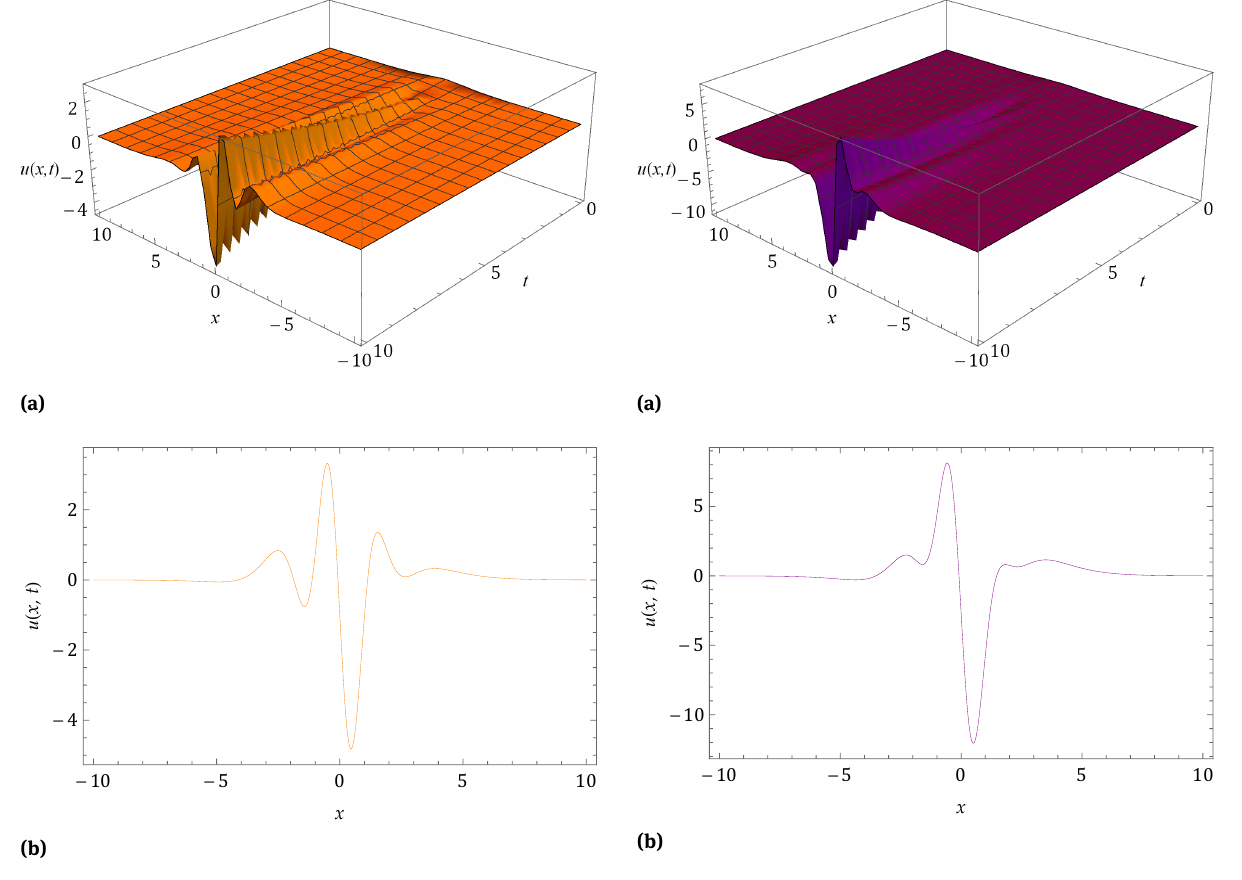
Figure 1: (a) Surface of u ( x , t ) , ( b ) 2D plot of u ( x , t ) at t = 10 at µ = 0.5, (cid:125) = −1, n = 1 and α = 0.5 .